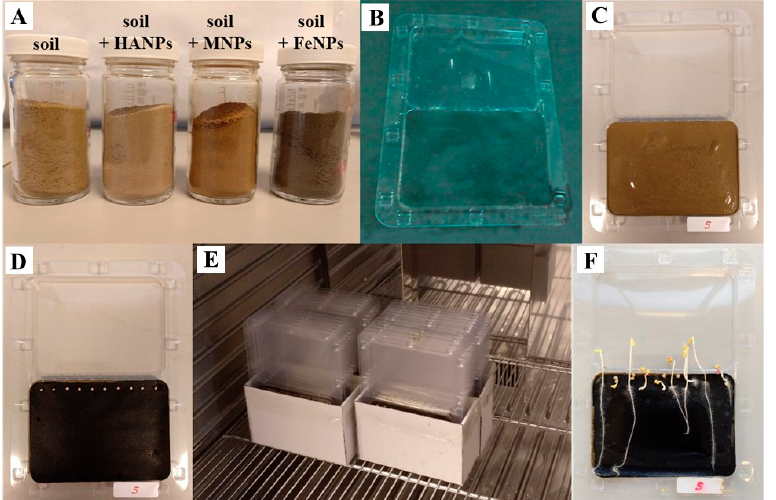
Figure 2. Stages of toxicity/tolerance bioassays (MicroBioTests Toxkit). ( A ) Soil samples with and without NPs; ( B ) Transparent plate; ( C ) Transparent plate with soil sample; ( D ) Transparent plate covered with a black filter and 10 seeds; ( E ) Transparent plate fit in the incubator camera; ( F ) Example of transparent plate with germinated seeds.